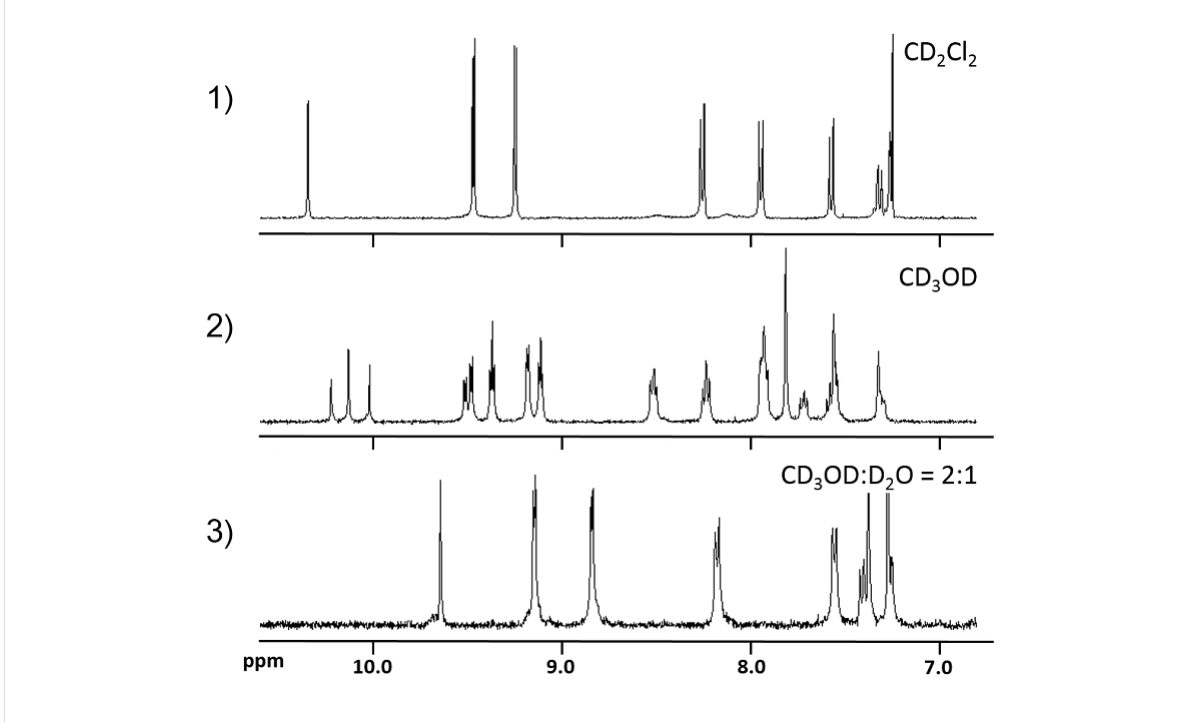
Figure 3: The aromatic region of the 1 H NMR spectra of 5 at 25 °C: 1) CDCl 3 , 2) CD 3 OD, and 3) CD 3 OD:D 2 O 1:1.